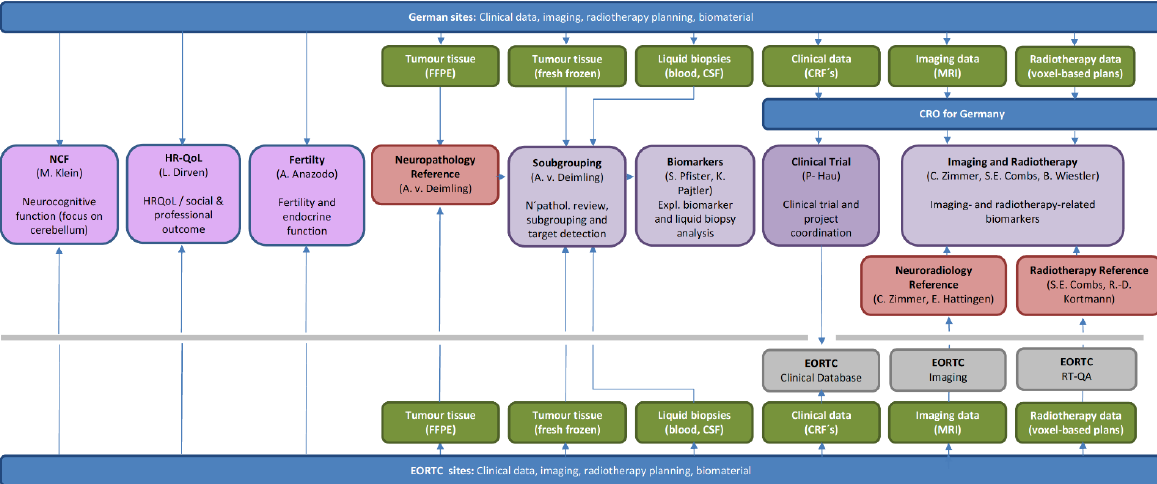
Figure 2. Graphic representation of the overall trial and translational project organization: EORTC is the sponsor of the trial, will host the trial in cooperation with Neuro-Onkologische Arbeitsgemeinschaft in der Deutschen Krebsgesellschaft (NOA), and ensure processing of clinical data, imaging data, and biomaterial that are analyzed within the translational subprojects. Reference sites for neuropathology, neuroimaging, and radiotherapy quality assurance have been defined and will directly receive biomaterial from sites and MRI images and voxel-based radiotherapy plans from the EORTC imaging platform and EORTC quality assurance in radiotherapy (RT-QA) platform. Neuro-cognition (NCF), health-related quality of life (HRQoL), and fertility and endocrine function will be assessed centrally. Responsible sites and principal investigators are named in the respective task boxes. WP = work package; FFPE = formalin-fixed paraffin-embedded; CSF = cerebrospinal fluid; CRF = case report form; MRI = magnetic resonance imaging; N’pathol = neuropathology; CRO = contract research